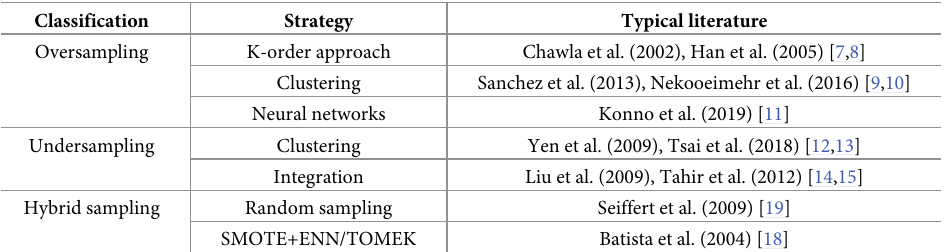
Table 1. Classification of typical algorithms for imbalanced sampling and representative